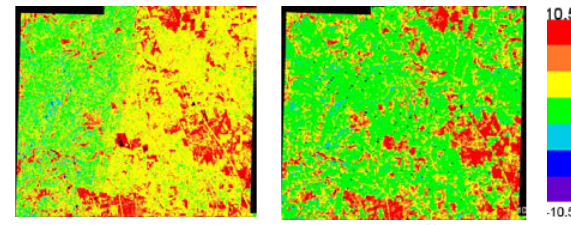
Figure 6. Test site Flat, color coded height differences against LiDAR, left: AW3D30, right: TDM90, color scale for both: +/-10.5m